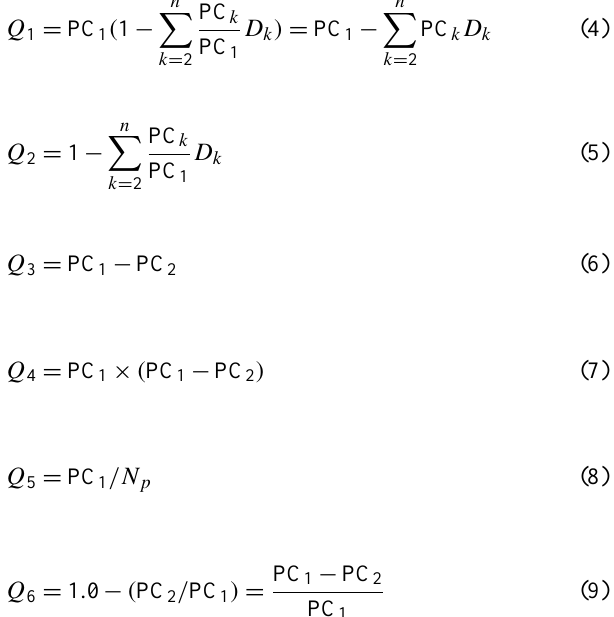
Fig. 2. The high-resolution part of the algorithm. The processing is shown here only for one window pair. In the algorithm, this is performed for each window pair with a grid step of (W/2,W/2) high- resolution